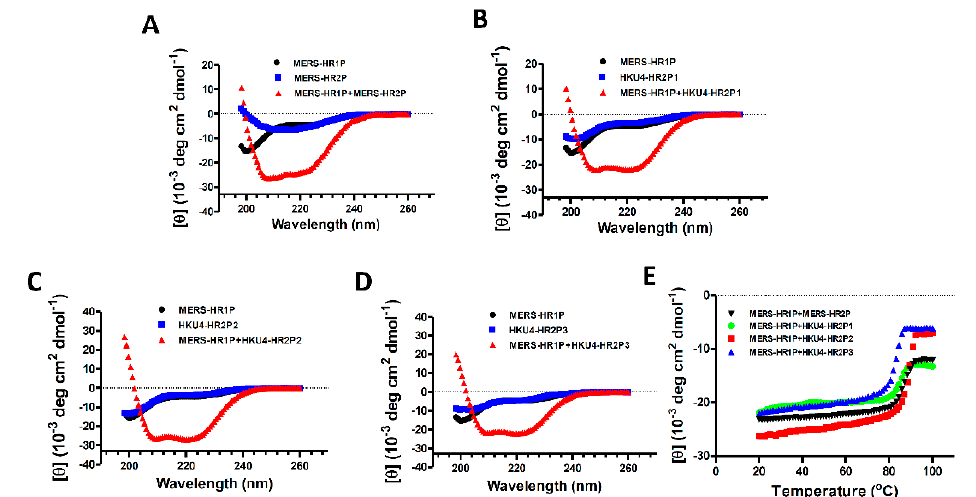
Figure 3. Circular dichroism (CD) spectra of MERS-HR1P, MERS-HR2P and MERS-HR1P/MERS-HR2P complex (A), MERS-HR1P, HKU4-HR2P1 and MERS-HR1P/ HKU4-HR2P1 complex (B), MERS-HR1P, HKU4-HR2P2 and MERS-HR1P/ HKU4-HR2P2 complex (C), MERS-HR1P, HKU4-HR2P3 and MERS-HR1P/ HKU4-HR2P3 complex (D) in phosphate buffer (pH 7.2). (E) Melting curves of the complexes formed by MERS-HR1P and MERS-HR2P, HKU4-HR2P1, HKU4-HR2P2, or HKU4-HR2P3, respectively.